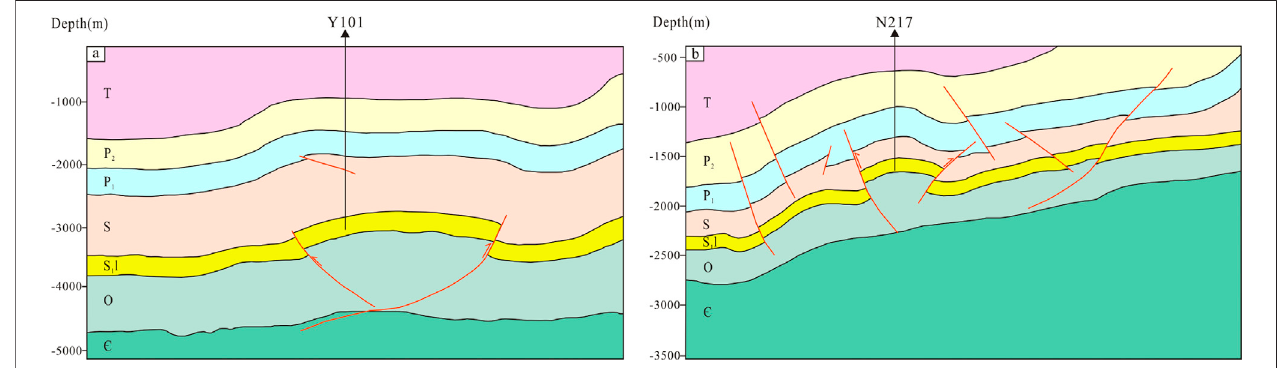
FIGURE 6 | Back thrust reverse fault assembly. (A) Cross Y101 well pro fi le in Luzhou area. (B) Cross N217 well pro fi le in Changning area.